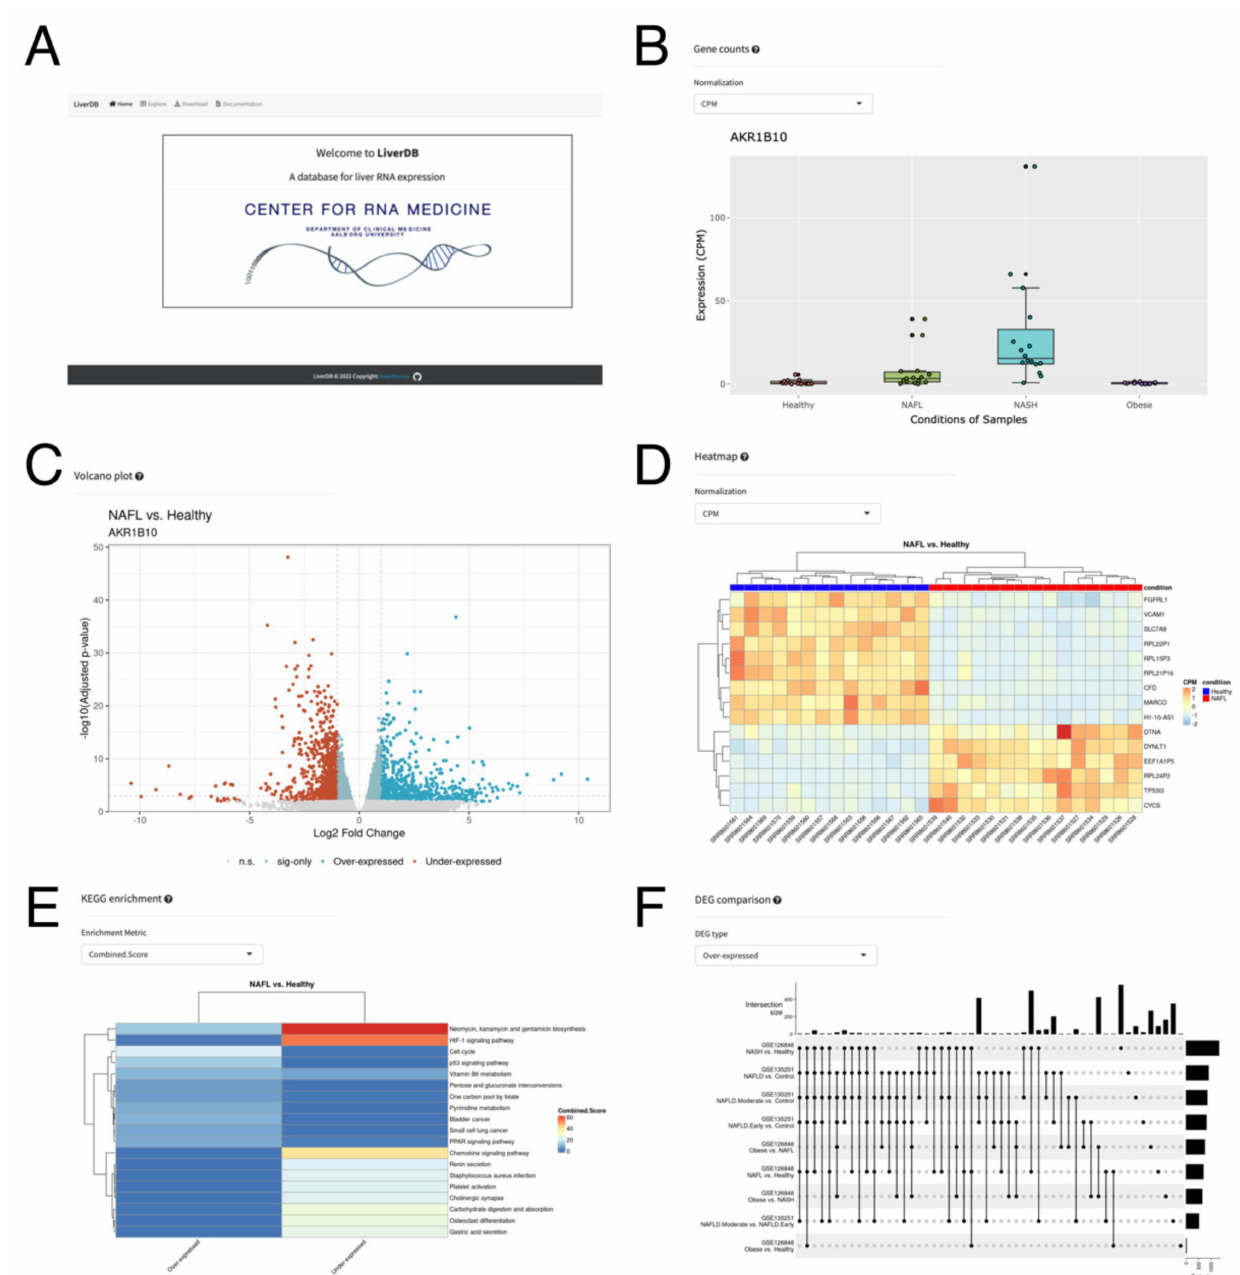
Figure 5. LiverDB. ( A ) The top page of LiverDB. ( B ) An interactive box plot showing the distribution of gene expression values across samples within each biological condition in the selected study. ( C ) A volcano plot of selected comparative conditions. ( D ) A heatmap of differentially expressed genes. ( E ) A pathway enrichment plot displaying the top results from KEGG pathway analysis as a heatmap. ( F ) An UpSet plot showing the number of differentially expressed genes that are found across study/contrast